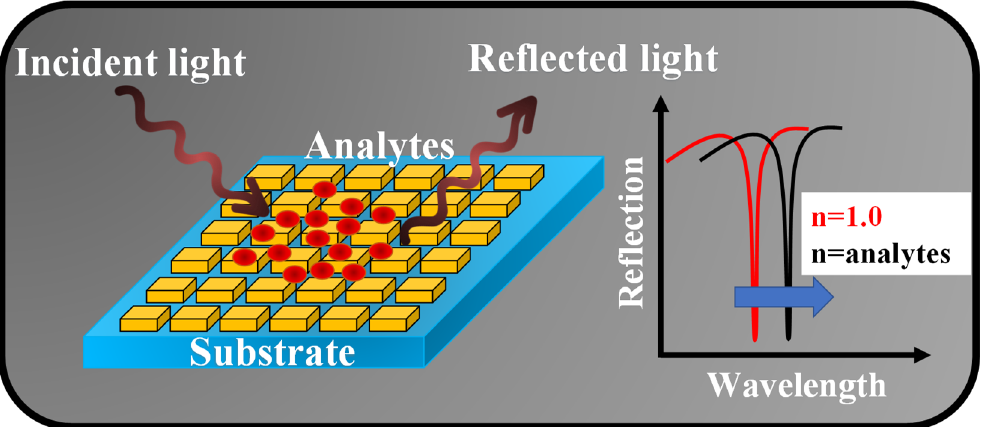
Figure 3. Sensing mechanism of an MS device based on the wavelength interrogation